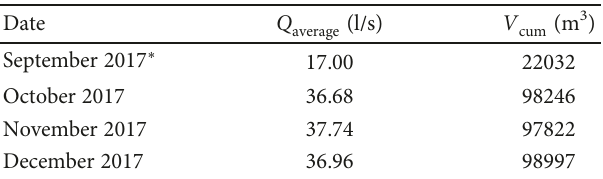
Table 3: Average fl ow rates and cumulated water volumes exploited in the Tulliola well.